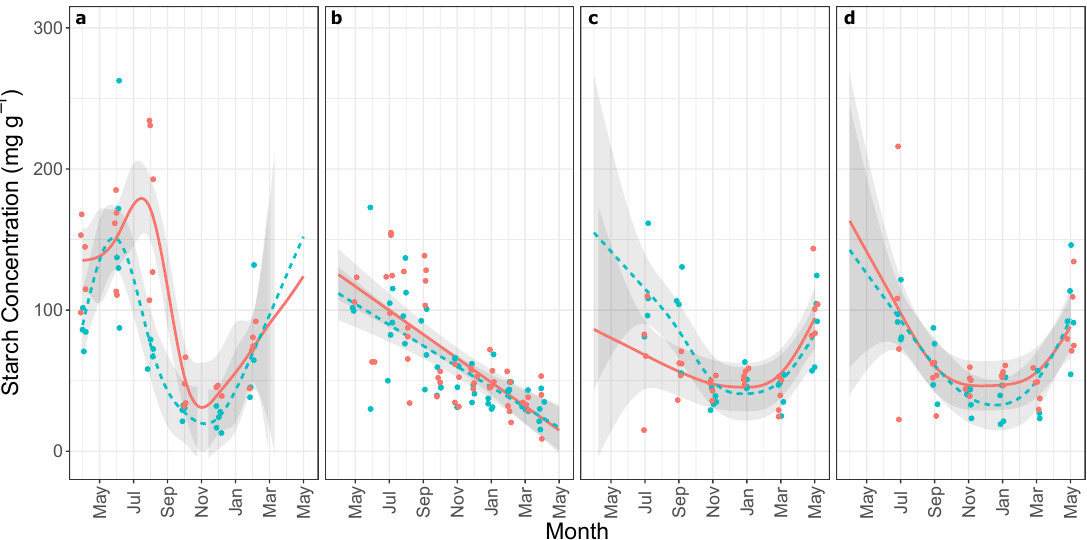
Figure 1. Mean starch concentrations (and 95% confidence band) from xeric (red solid) and mesic (blue dashed) populations of Pinus palustris collected between April 2013 and May 2014 from coarse lateral roots ( a ), stem at breast height ( b ), mid canopy branches ( c ), and upper canopy branches ( d ); estimated by generalized additive model (ten thin-plate regression splines using REML). For visibility, data points are jittered ± 0.2 months along the x-axis (jittering not used in